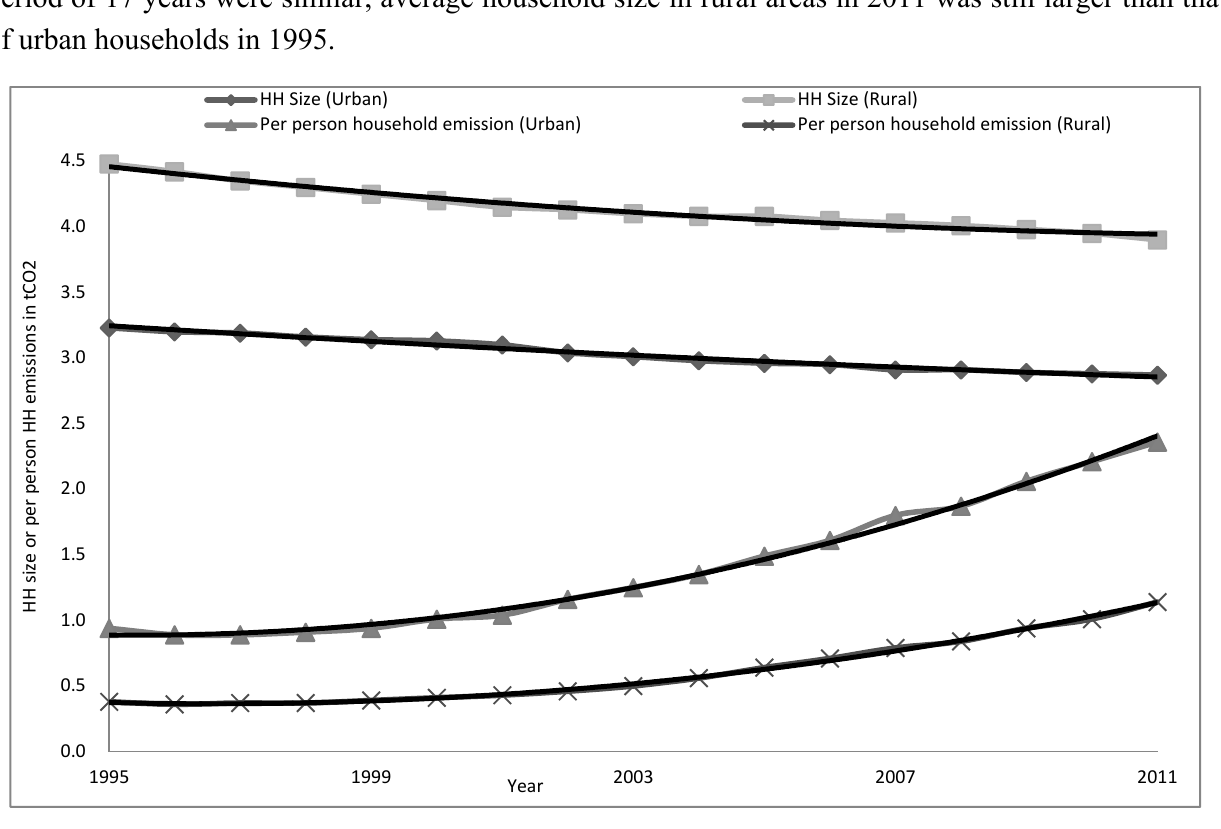
Figure 5. Relationship between the household size and per person HCEs in urban and rural